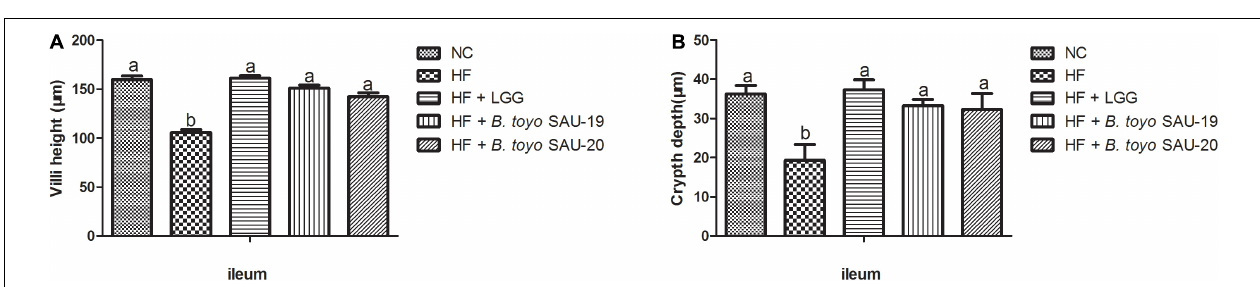
FIGURE 3 | Effects of Bacillus toyonensis SAU-19 and SAU-20 on the villi height and crypt depth of small intestine in mice fed high fat diet. (A) Villi height of ileum in mice. (B) Crypt depth of ileum in mice. The values are presented as the mean ± SD. Bars without the same letter differed significantly ( n = 4, P < 0.05). NC, mice were administered normal diet + normal saline; HF, mice were fed high fat diet + normal saline; HF + LGG, mice were administered high fat diet + 10 6 Lactobacillus rhamnosus GG; HF + B. toyo. SAU-19, mice were administered high fat diet + 10 6 Bacillus toyonensis SAU-19 from A. adenophora ; HF + B. toyo. SAU-20, mice were administrated with high fat diet + 10 6 Bacillus toyonensis SAU-20 from A. adenophora